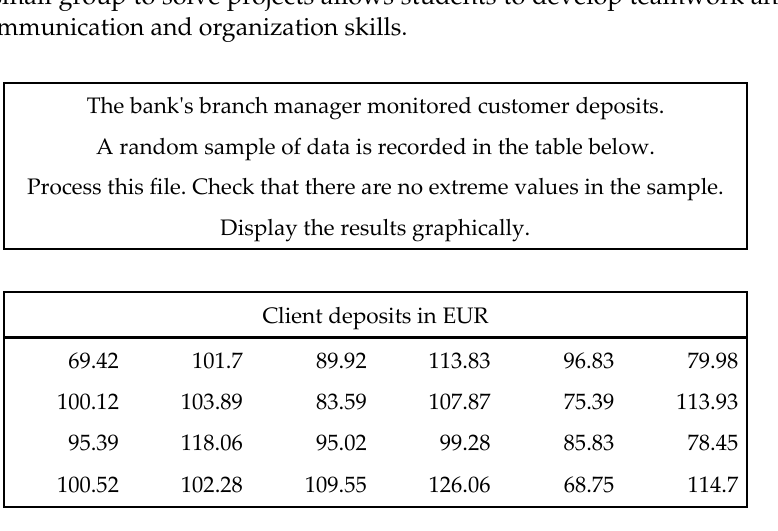
Figure 3. A sample of the example in the numerical exercise.